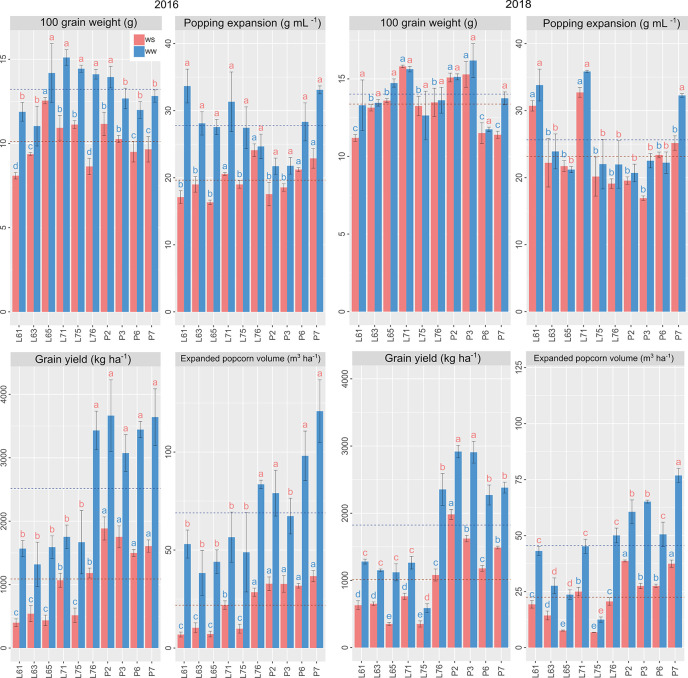
Agronomic potential of popcorn inbred lines under WS and WW conditions in 2016 and 2018. Mean genotypes, red (WS) and blue (WW), followed by the same letter do not differ using the Scott and Knott test at 5%. The bars denote the standard error.